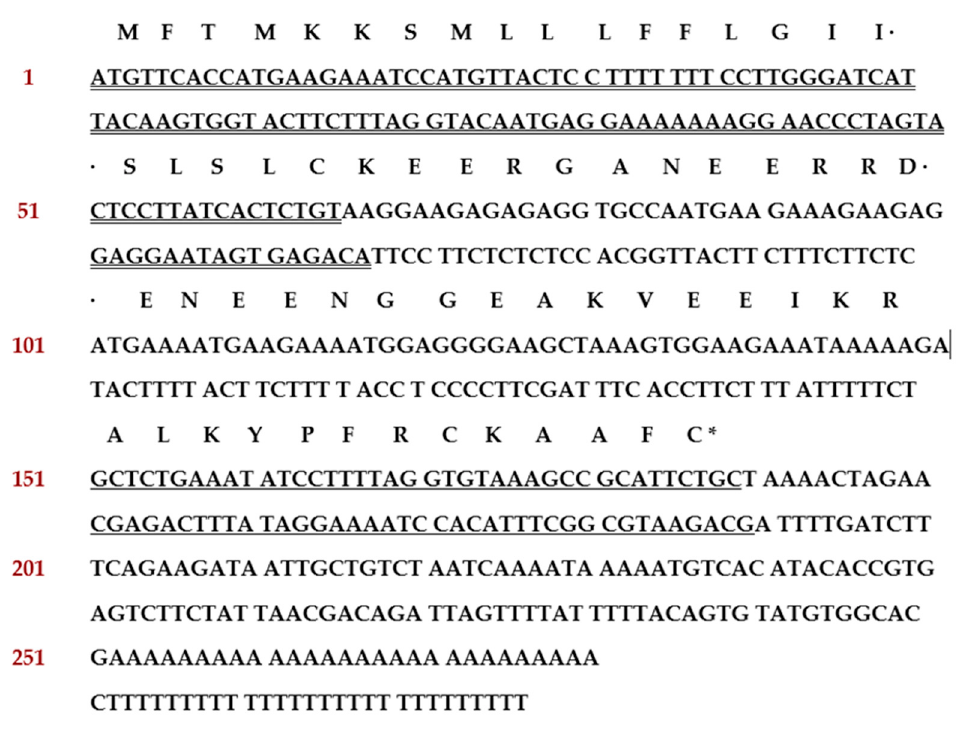
Figure 1. The open-reading frame of the biosynthetic precursor of Kunitzin-OV. The putative signal peptide is double-underlined, the mature peptide is single-underlined, and an asterisk indicates the stop codon.